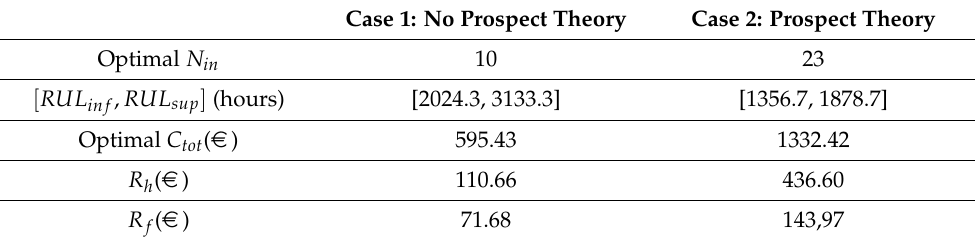
Table 5. Optimization results under both cases (no prospect theory and prospect theory) for ρ discard =